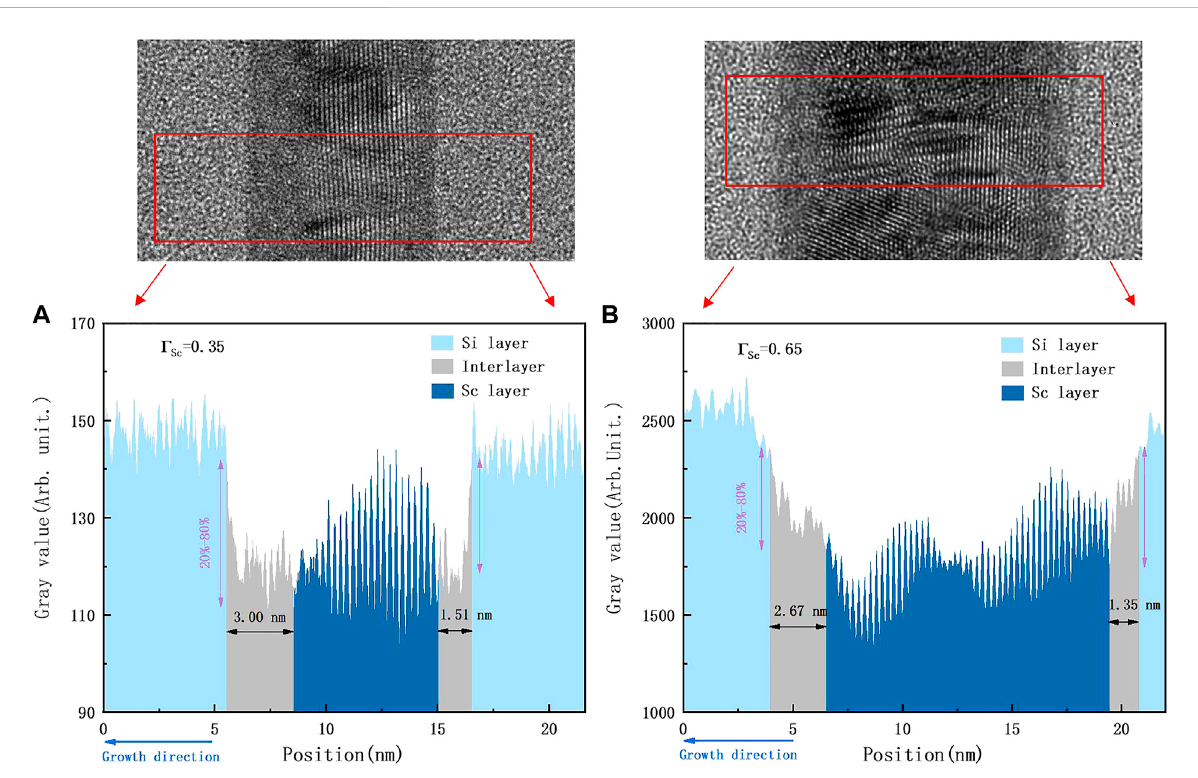
crystal phases was enhanced, and most of the Sc grains grew along the direction of the multilayer growth. The average gray-value pro fi les of the Sc/Si multilayers obtained near the middle of the multilayer are shown in Figure 6. The Y axis represents the average reading gray values along the growing direction of the multilayer. The X axis represents the observed position along the direction of the multilayer growth, and 20% of the peak and valley difference in the selected area was de fi ned as the interface width [23]. The peak value was chosen from the Si layer near the edge, and the valley value was chosen from the internal Sc layer. The purple arrows marked the selected peak and valley values in Figure 6. At the top of the gray-scale curve was the selected area in the TEM images in Figures 5B and E, which were rotated by 90 ° . For the Sc/Si multilayer with Γ Sc = 0.35, the thickness of the interlayer at the Si-on-Sc and Sc-on-Si interfaces was approximately 3.00 and 1.51 nm, respectively. For the Sc/Si multilayer with Γ Sc = 0.65, the thickness of the interlayer at the Si-on-Sc and Sc-on-Si interfaces was approximately 2.67 and 1.35 nm,